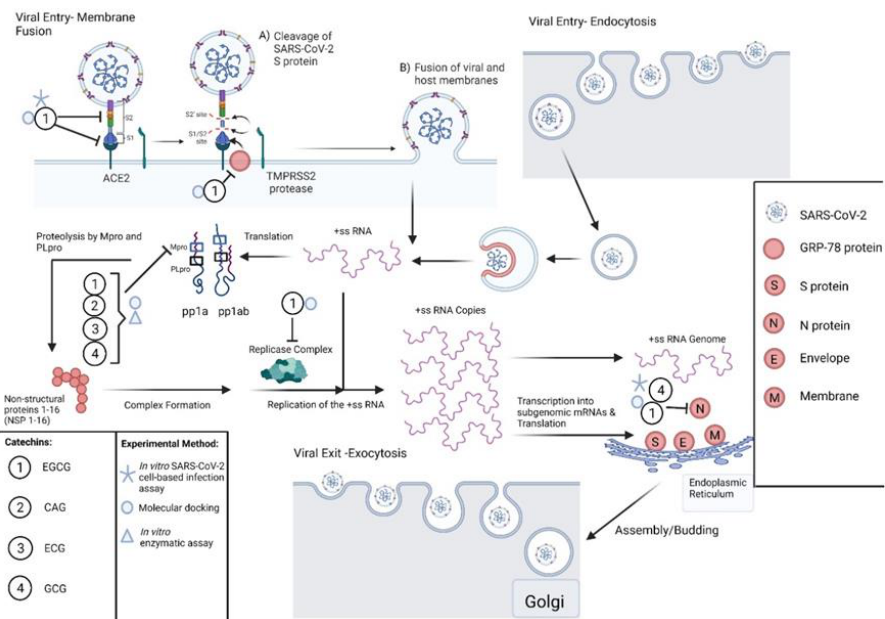
Figure 2. Catechins exert anti-SARS-CoV-2 activities by targeting different steps of the SARS-CoV-2 lifecycle. Catechins, such as EGCG, bind to SARS-CoV-2 S protein and inhibit its binding to the ACE2 receptor. EGCG also binds to GRP-78, which potentially blocks its binding to S protein, which may inhibit viral entry. EGCG, ECG, CAG and GCG inhibit Mpro of SARS-CoV-2, which blocks viral replication. Molecular docking studies have shown that EGCG binds to RNA-dependent RNA polymerase and other proteins of the replicase complex (NSP6 and NSP15) which may block viral replication. Furthermore, EGCG and GCG bind to and inhibit association of N protein with the RNA genome blocking viral assembly. This figure was created with BioRender.com (ac- cessed 25th July 2021).